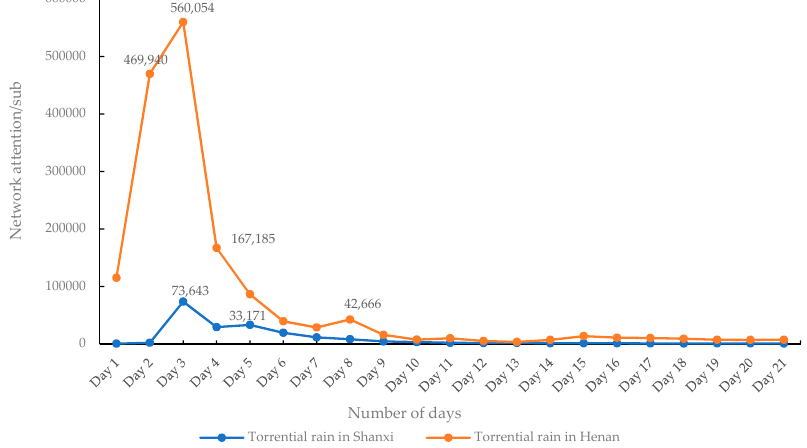
Figure 3. Trend of daily national internet attention for torrential rain in Shanxi and Henan.